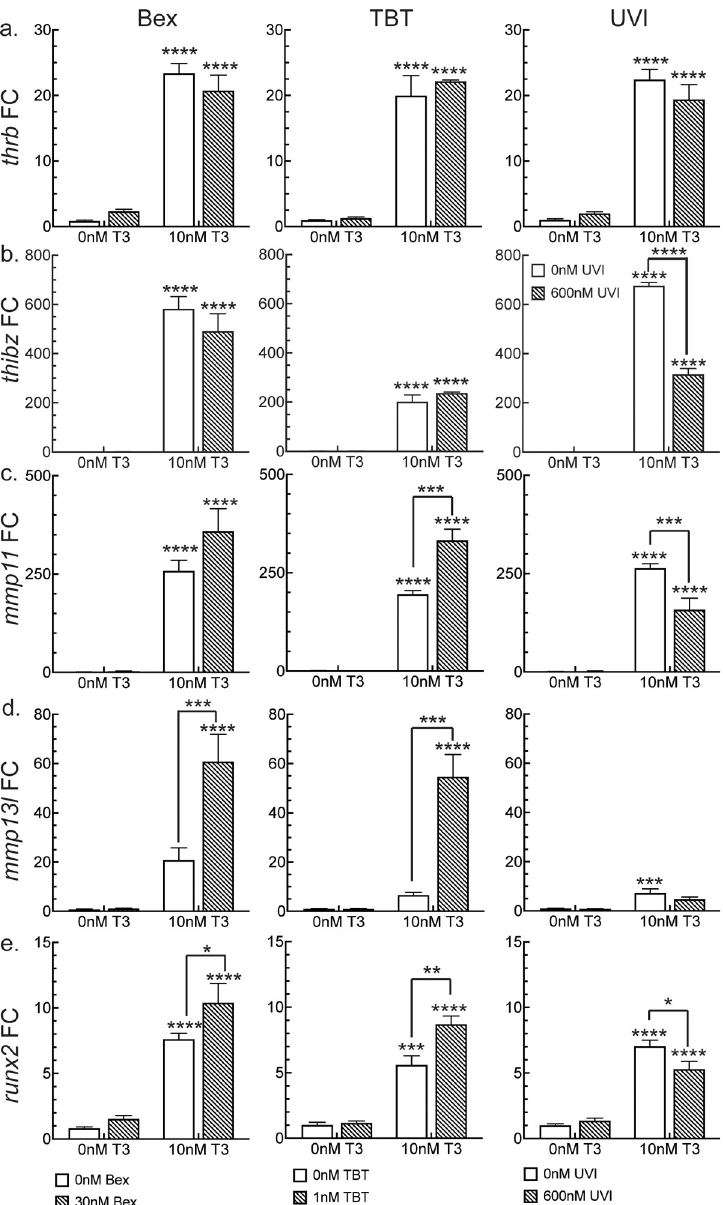
Fig 4. RXR ligands have gene-specific effects on T3-induced differential gene expression. Left column: The effect of RXR agonist Bex on T3-induced gene expression. Middle column: The effect of environmental RXR agonist TBT on T3-induced genes. Right column: The effect of RXR antagonist UVI on T3-induced genes. Striped bars indicate the presence of the RXR ligand, and white bars show induction in the absence of the RXR ligand. Statistics show results from Sidak’s multiple comparison test in conjunction with 2-way ANOVA ( ���� , p < 0.0001; ��� , p < 0.001; �� , p < 0.01; � , p < 0.05).